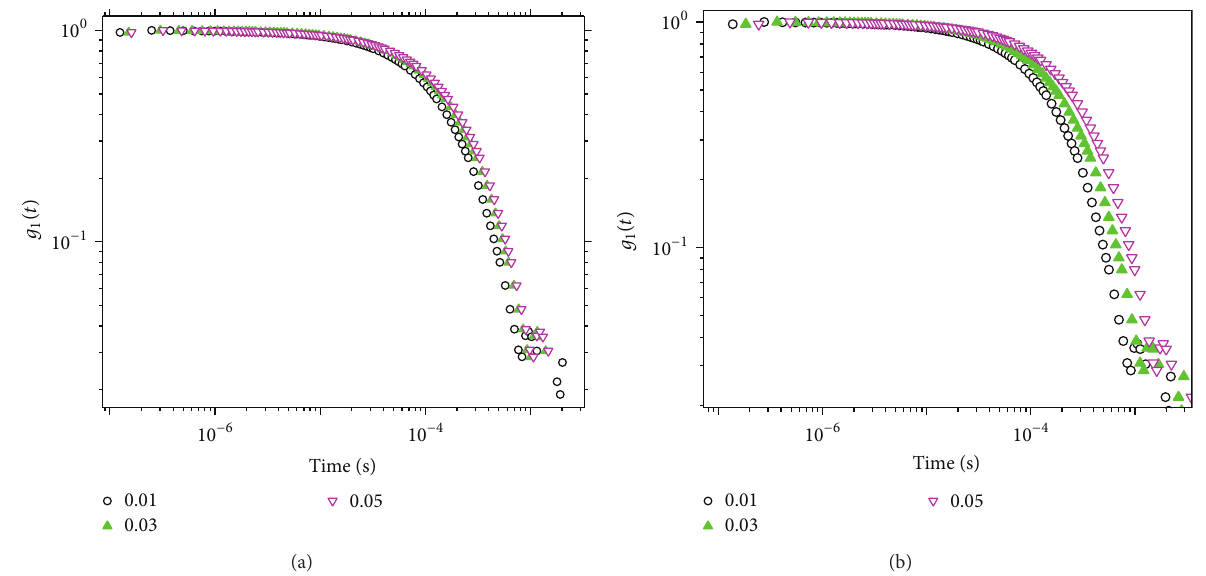
Figure 1: First-order field correlation function versus time for a mixture of C 12 E 5 microemulsion with PCL at droplet mass fraction (0.2) and /𝑚 𝑚 = 1.08 and different mass fractions of PCL (0.01, 0.03, and 0.05). (a) PCL with M.W. = 5000 and (b) PCL with M.W. = Dec C 12 E 5